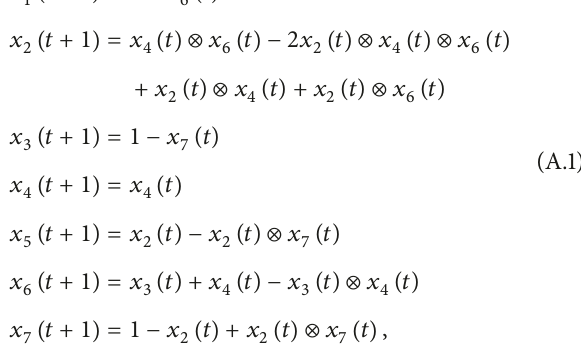
Figure 8: Dynamics of the Boolecube model of Drosophila segment polarity genes interactions with initial state conditions 𝑋(0) = [0.5;0.7; 0.7; 0.7; 0.7; 0.7; 0.7; 0.7; 0.7; 0.7; 0.7; 0.7; 0.7] . The Boolecube model reaches the point attractor in 7th iteration 𝑋(7) = [0.5; 0; 0;0.45; 0.45; 0.2; 0.2; 0; 0;0.55; 0.55; 0; 0.55]